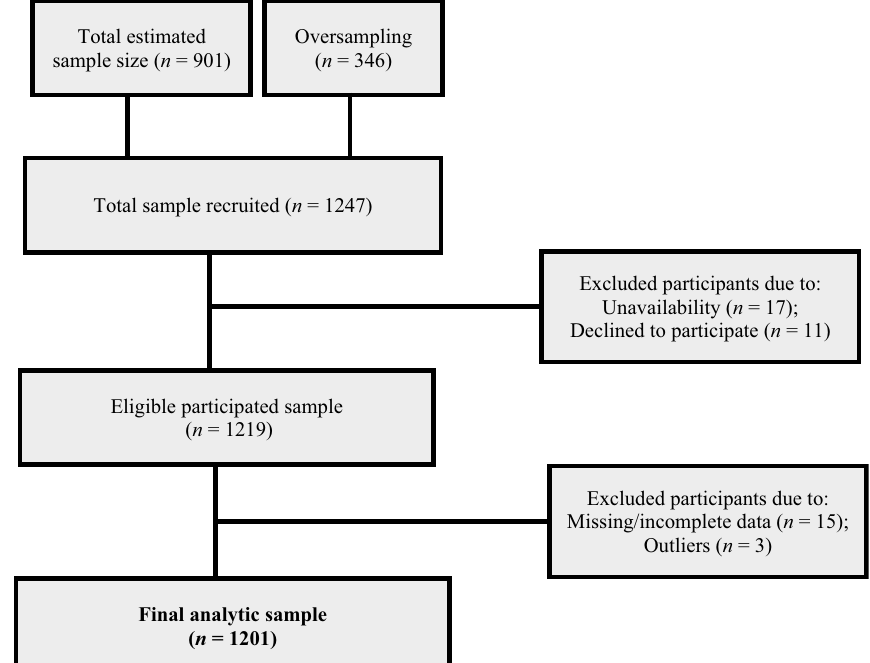
Figure 1. Flow chart of the selection of study participants.